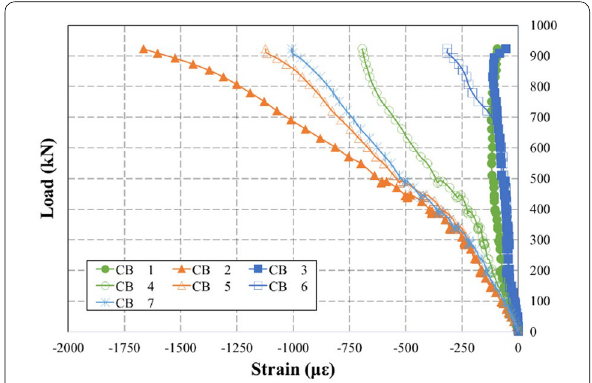
Fig. 14 BD load–concrete strain curve.